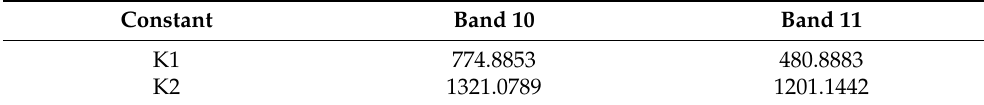
Table 6. Constant value (K1, K2) for bands 10,